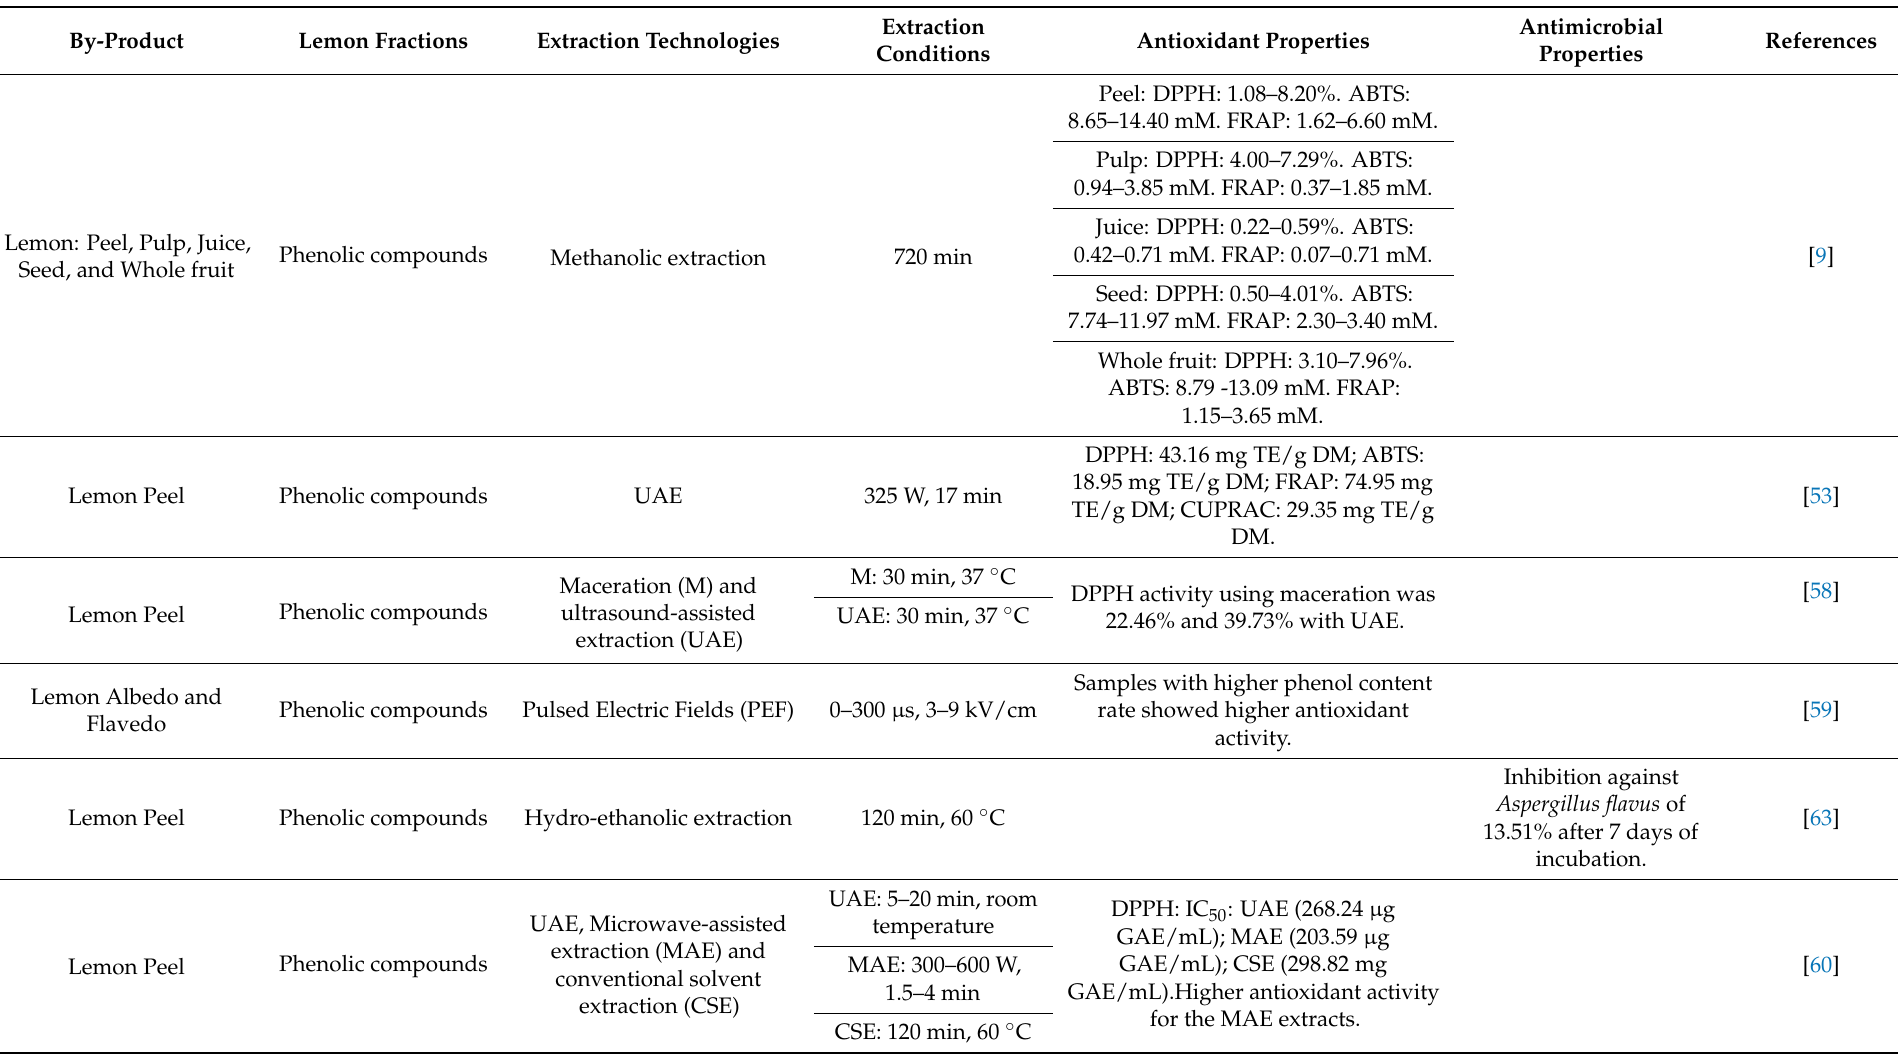
Table 4. Extraction technologies and bioactive properties of phenolic compounds from lemon